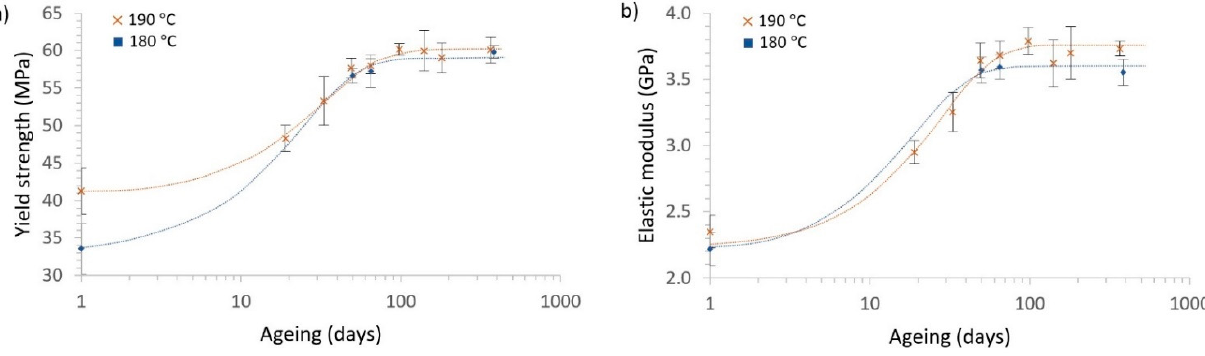
Table 3. Logistic fitting parameters and the relative variation (%) of each of them. Parameter